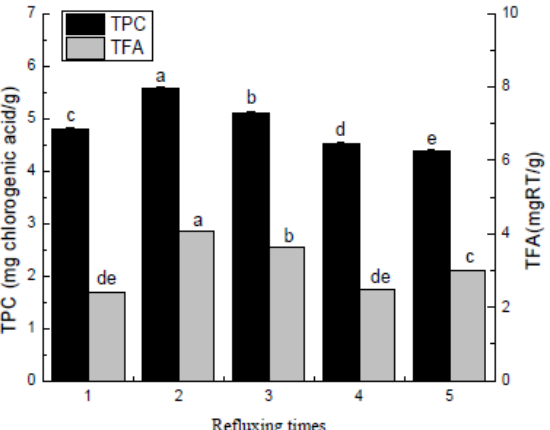
Figure 5. Refluxing times. Three independent experiments were carried out for each analysis. Result is expressed as a mean ± SD ( n = 3). Values with the different letters in the column are significantly different by Duncan’s multiple range test ( p < 0.05).